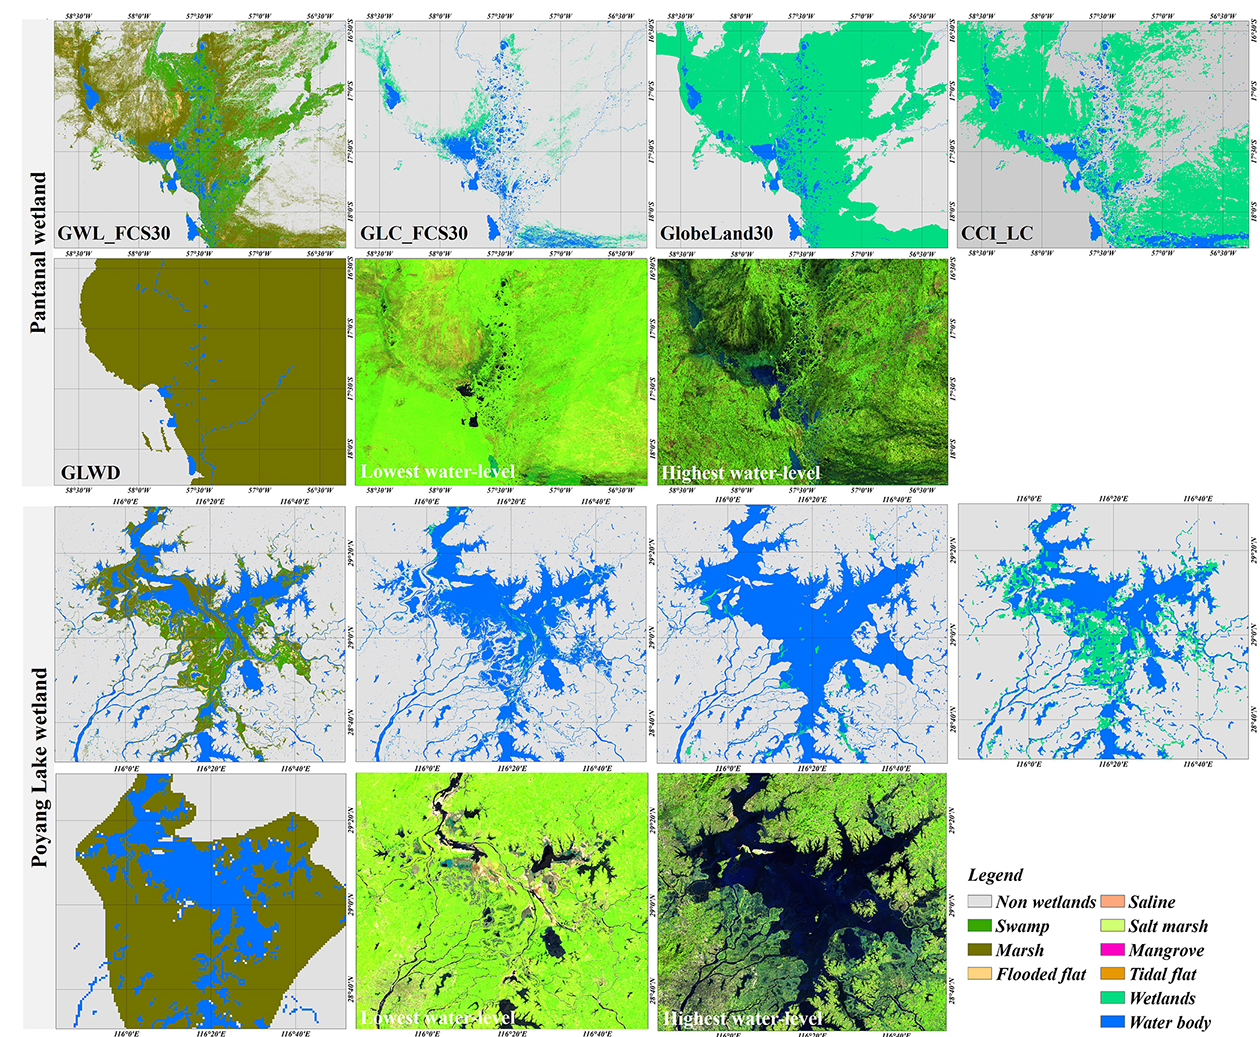
Figure 13. The cross-comparisons between our GWL_FCS30 wetland maps with four existing wetland products: GLC_FCS30 generated by Zhang et al. (2021b), GlobeLand30 generated by Chen et al. (2015), CCI LC generated by Defourny et al. (2018) and GLWD generated by Lehner and Döll (2004) at Pantanal and Poyang Lake wetland. The false-color composited Landsat imagery (SWIR1, NIR and red bands) at the highest and lowest water levels is also